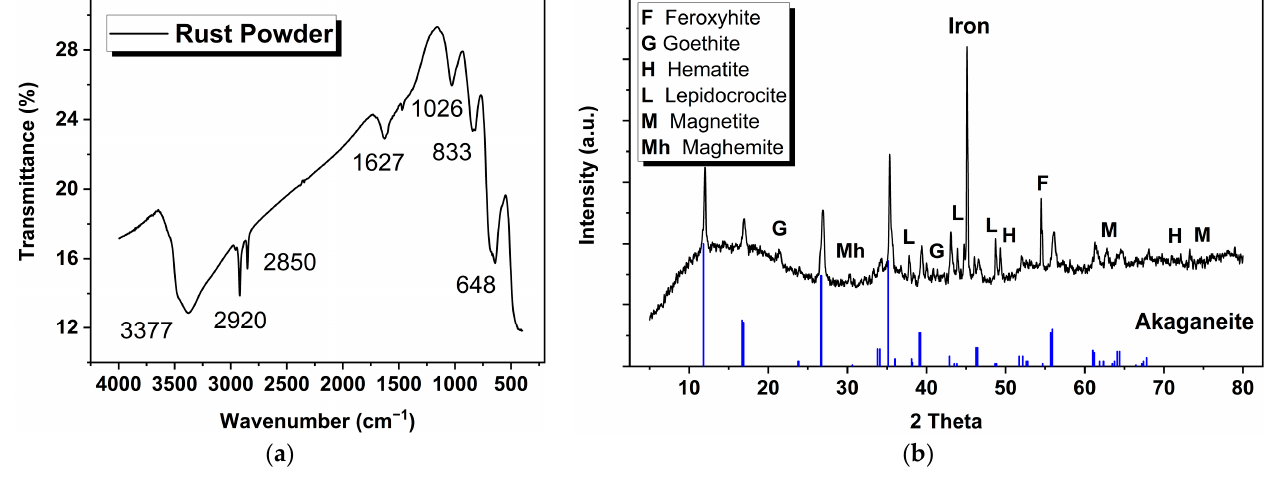
Figure 4. FTIR ( a ) and XRD ( b ) diagrams of rust powder.